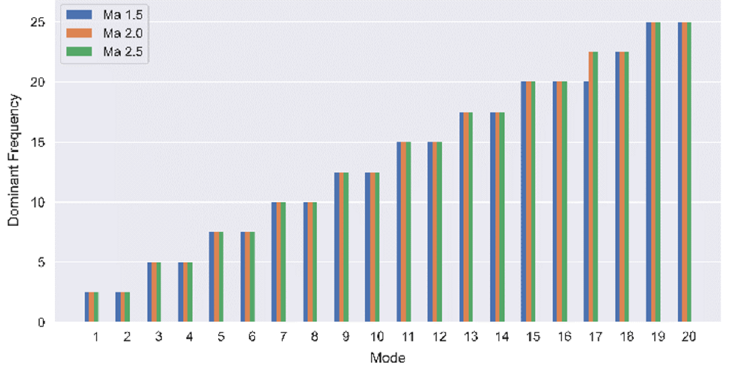
Figure 11. The dominant frequency of the first 20 modes behind the MVG in three different Mach numbers.